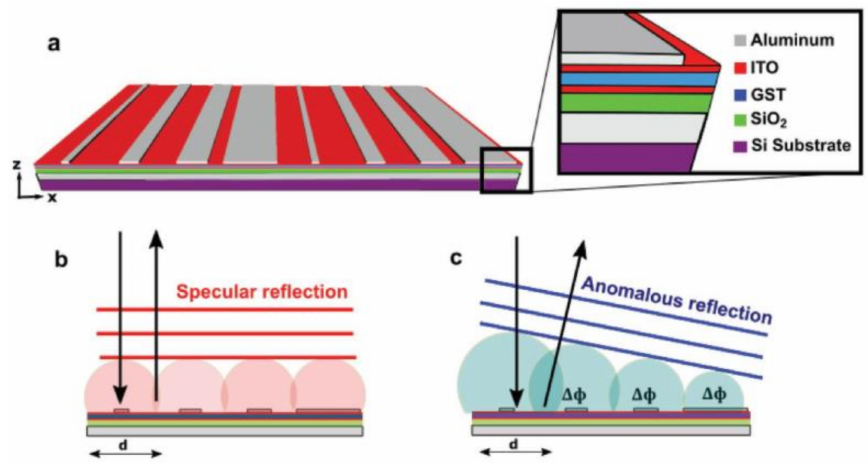
Figure 10. ( a ) Continuous metasurface with a 1D array of antennas configured in the MIM setup for beam steering by Wright’s group; ( b ) normal incidence and specular reflection in the crystalline state and ( c ) anomalous reflection in the amorphous state—all figures in ( a – c ) are reproduced with permission from [29].